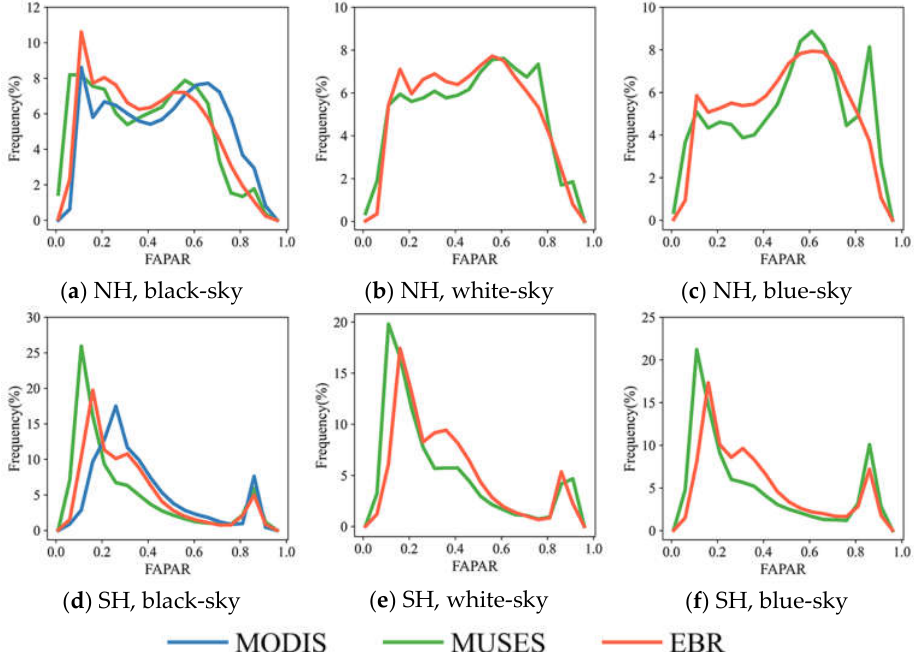
Figure 4. Histograms of the MODIS, MUSES and EBR FAPAR products in July of 2016 in the northern hemisphere (NH) (top) and southern hemisphere (SH) (bottom). ( a ) NH, black-sky. ( b ) NH, white-sky. ( c ) NH, blue-sky. ( d ) SH, black-sky. ( e ) SH, white-sky. ( f ) SH, blue-sky. For broadleaf crops, most black-sky, white-sky and blue-sky FAPAR values are between 0.1 and 0.8. The histograms of the MUSES black-sky, white-sky and blue-sky FAPAR values are bimodal, but the histograms of the black-sky, white-sky and blue-sky FAPAR values for the MODIS and EBR products have only one